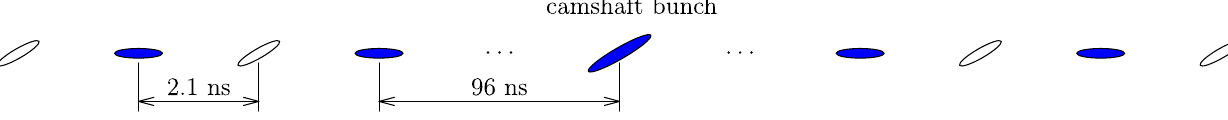
FIG. 1. Bunch pattern for the SPEAR3 2FCC mode. The camshaft bunch current is 20 mA in a single bunch. The total regular beam current is 480 mA, equally distributed in 138 nontilted bunches